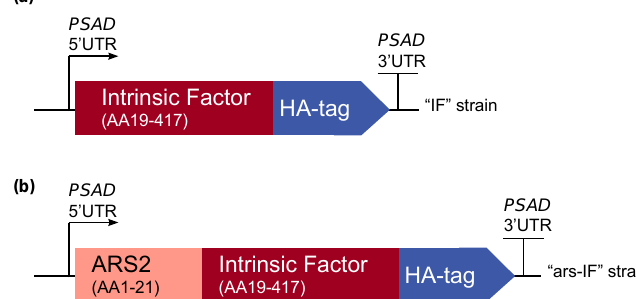
Figure 1. Overview of the intrinsic factor (IF) expression cassettes used for C. reinhardtii transformation. The strains expressing the constructs have been named “IF” and “ars-IF” respectively. The 3 ′ and 5 ′ untranslated regions of the C. reinhardtii PSAD gene are used for gene expression. ( a ) The N-terminal native signal peptide of the human IF protein was removed and the full length protein was codon-optimized for C. reinhardtii nuclear expression. A C-terminal human influenza hemagglutinin (HA) epitope tag was added to the protein for detection purposes. ( b ) Additionally, a second version of IF was constructed with the secretion signal peptide of arsylsulfatase